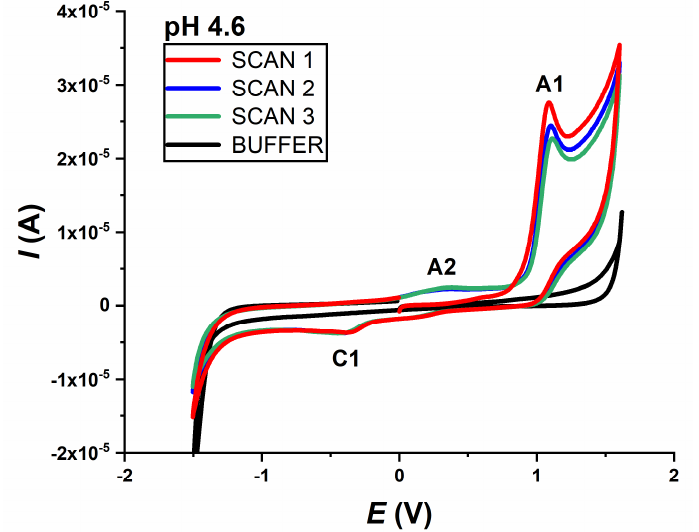
Figure 1. The CVs of 0.2 mmol L − 1 IVM in acetate buffer pH 4.6, starting from 0.0 V, recorded in the positive potential direction; first ( ── ), second ( ── ), third ( ── ) and buffer scan ( ── ); ν = 50 mV s −1 .